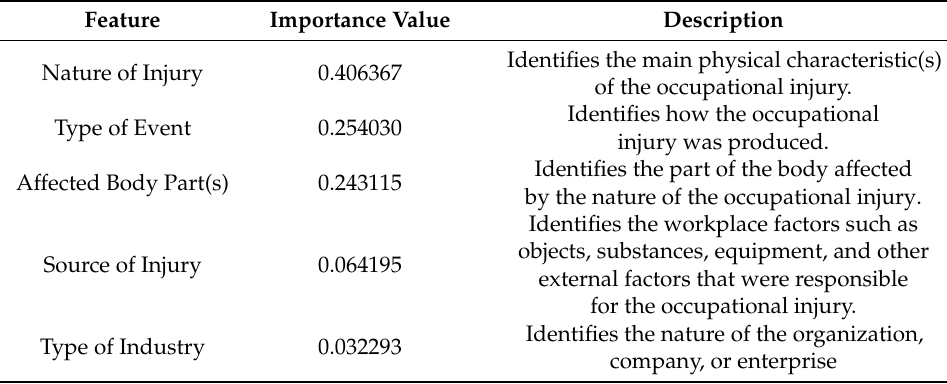
Table 5. Feature Importance based on Ranking.